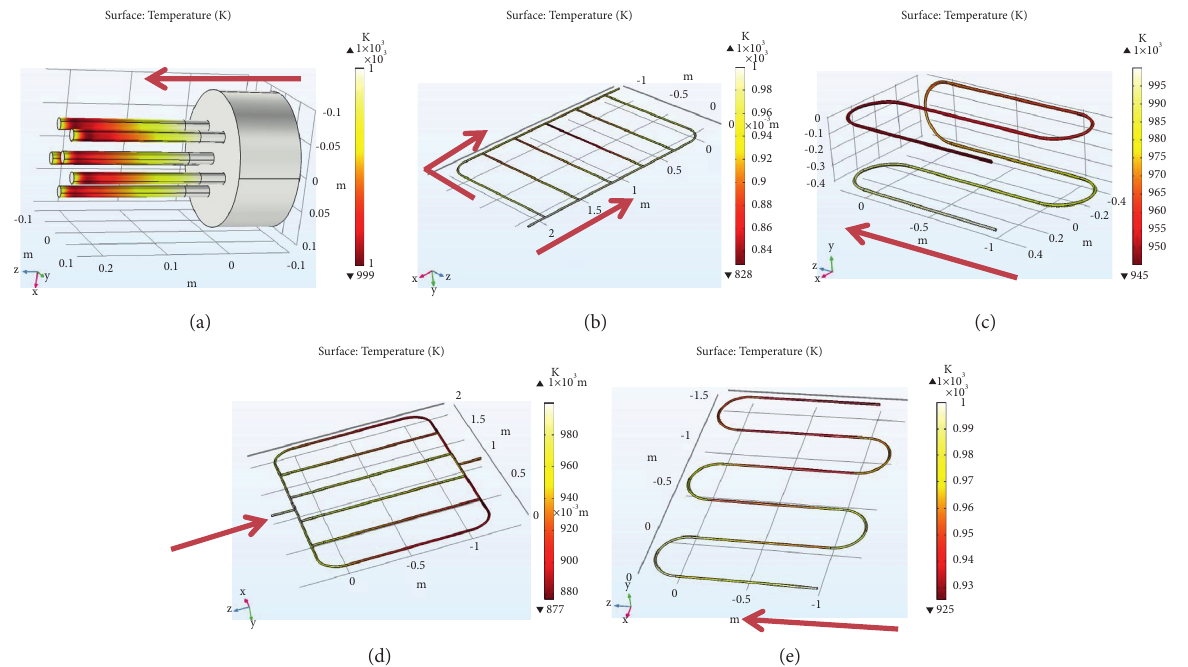
Figure 9: Heat source configurations for the realization of Figure 8. The arrows indicate the flow